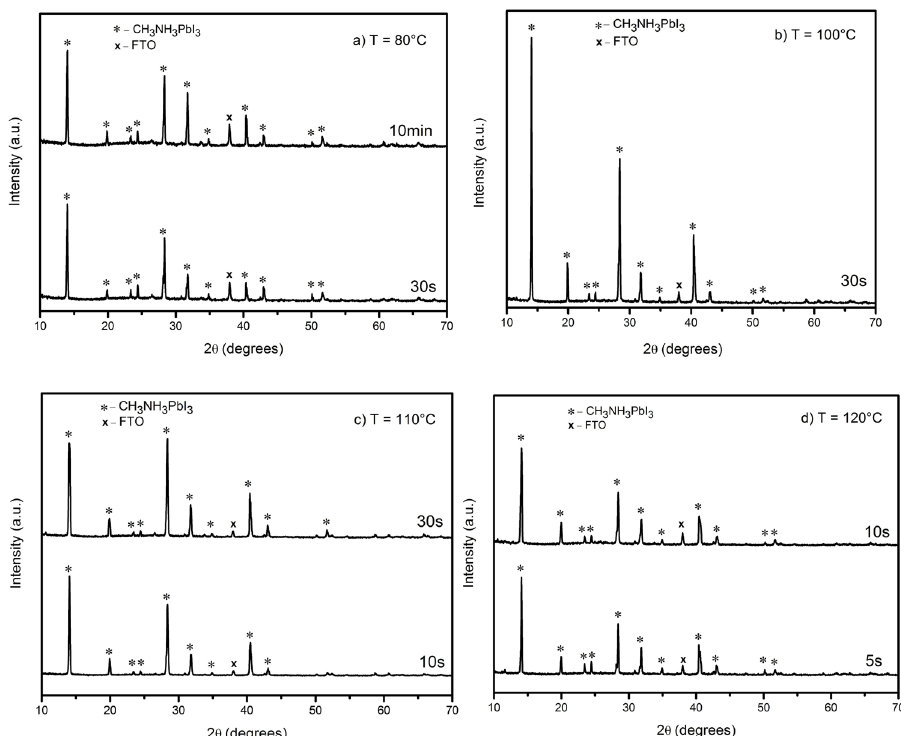
Figure 3. XRD patterns of the treated perovskite 24-h films fabricated via spray deposition at different temperatures and annealing times: a) 80 o C; b) 100 o C; c) 110 o C; d) 120 o